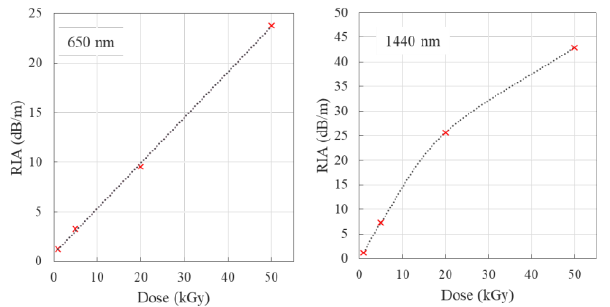
Fig. 5. RIA dependency on the irradiation dose at two wavelengths.